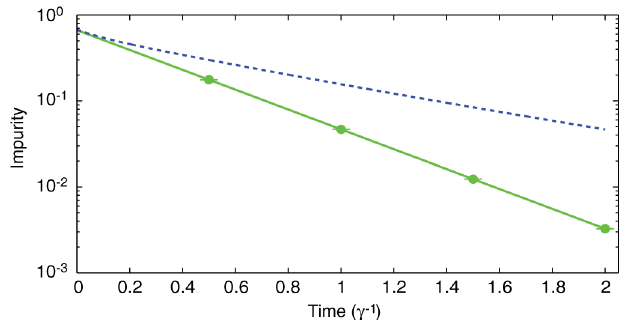
FIG. 3. Trajectory simulations of the impurity for a D ¼ 3 system subject to feedback every (cid:7)t ¼ 10 (cid:2) 3 (cid:2) (cid:2) 1 in order to keep the state and measurement eigenbases complementary. The ensemble size is 100. The dashed line is h L i for a continuous-commuting measurement ( D ¼ 3 ), i.e., Eq. (7). The solid line is the numerically calculated ensemble average of h L i for the complementary measurement; it is plotted in green, and error bars are plotted at times ð 0 : 5 ; 1 ; 1 : 5 ; 2 Þ (cid:8) (cid:2) (cid:2) 1 . The analytic expression for the average impurity, Eq. (23), is indis- tinguishable from the results of the